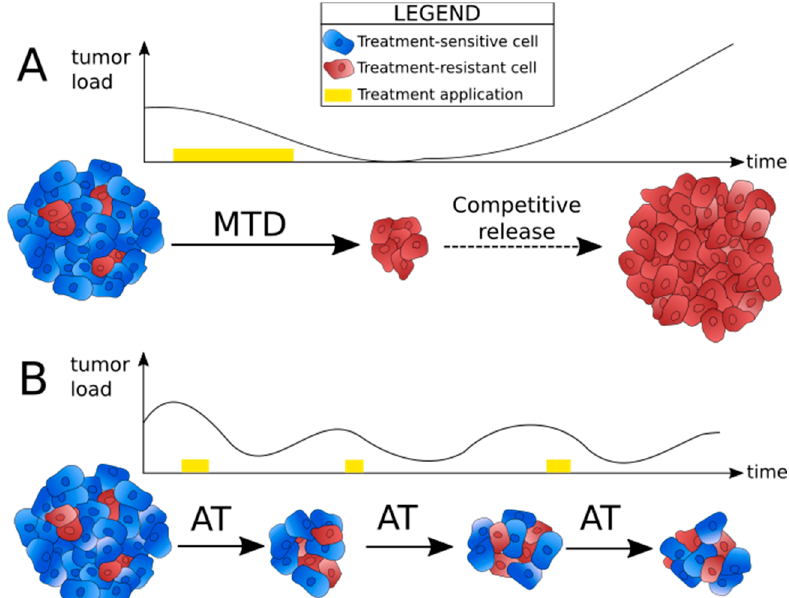
Figure 1. Principle of adaptive therapy. ( A ) Tumor load evolution under maximum tolerated dose (MTD) strategy. Treatment is applied continuously and at a constant dose (yellow band). Competitive release causes recurrence and treatment failure. ( B ) Tumor load evolution under adaptive therapy (AT) strategy. The on/off cycles and drug dose are adjusted to the progression of the tumor in the patient (yellow bands), and the aim is to contain the tumor at a manageable load for as many cycles as possible.